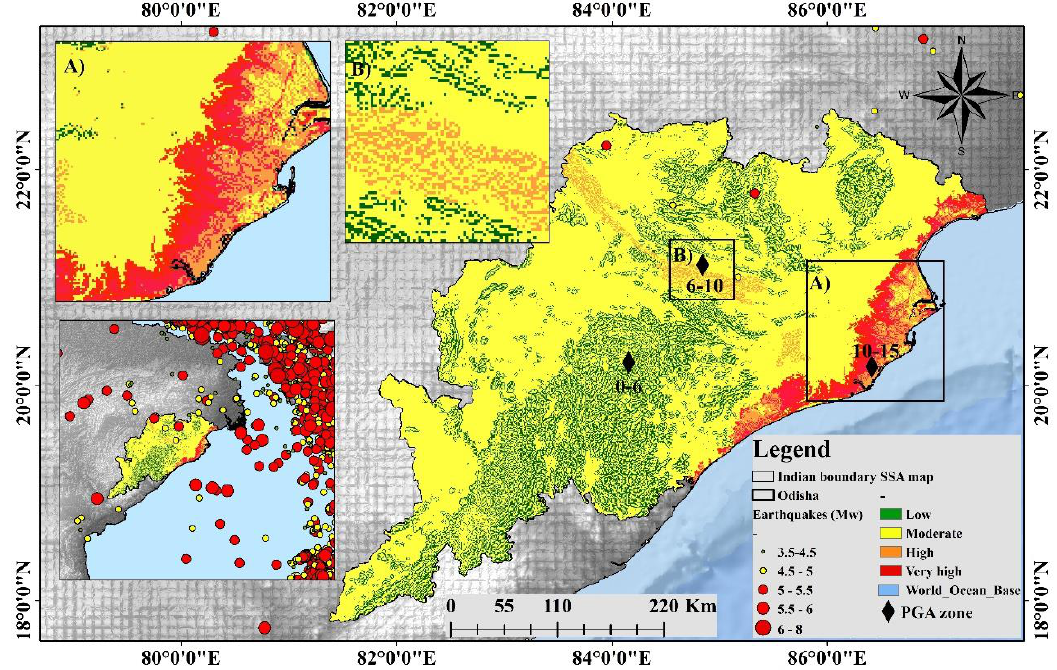
Figure 7. SSA assessment for Odisha.